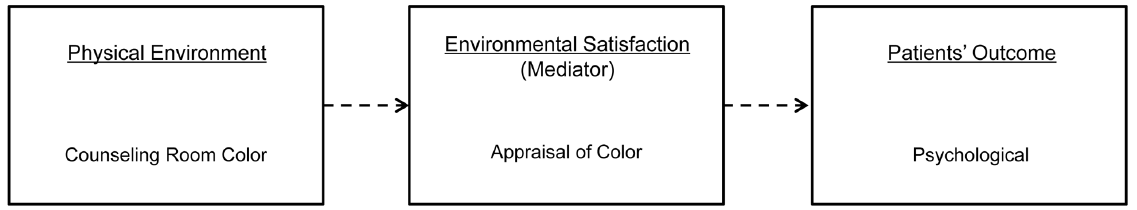
Figure 1. Conceptual model of the impact of color on patients’ outcome.